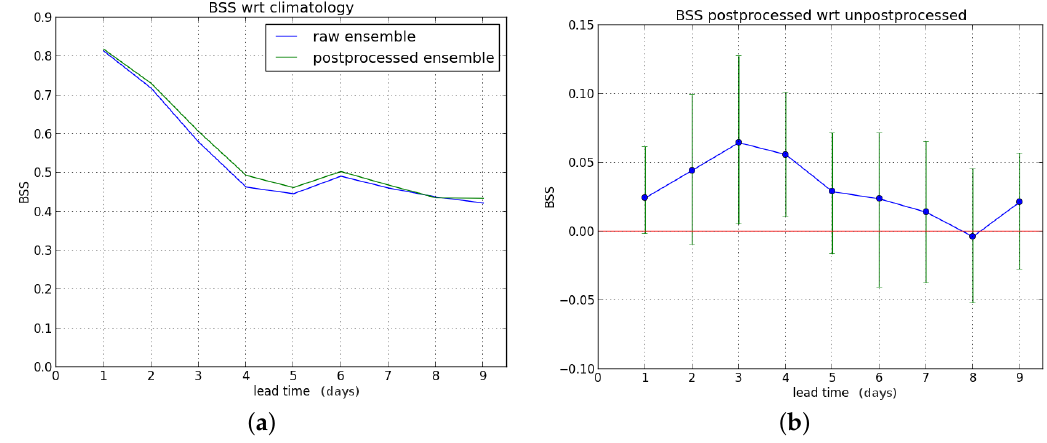
Figure 7. Brier Skill Score for the P90 threshold. Comparison with reference discharge, entire verification period. ( a ) Compared to sample climatology; ( b ) Improvement due to postprocessing.